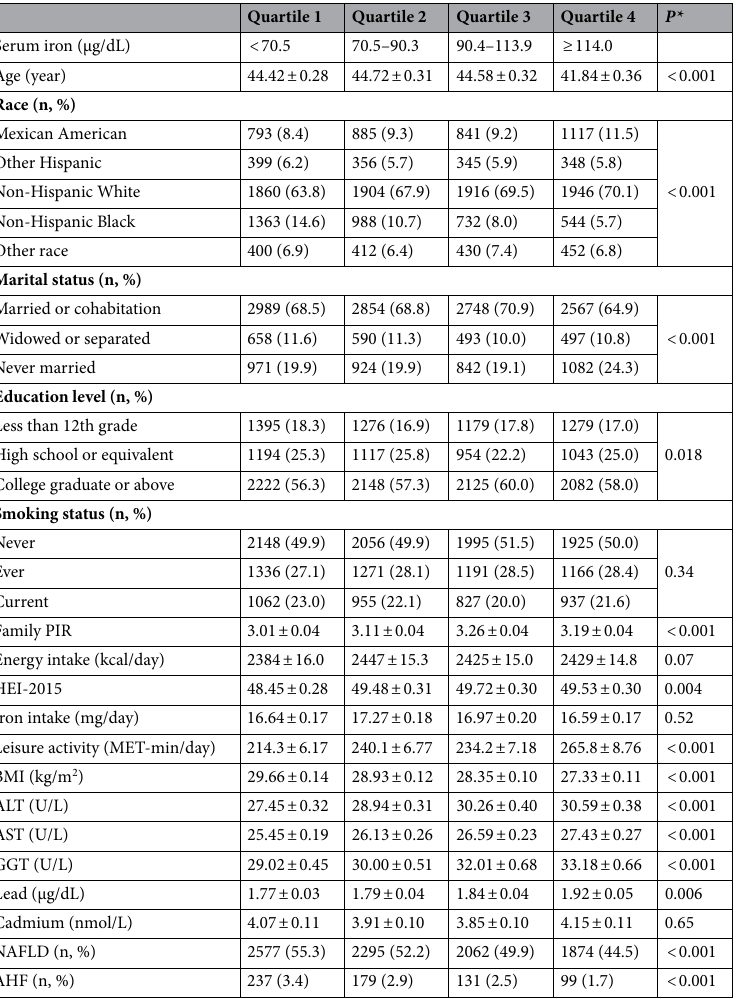
Table 1. Basic characteristics of participants according to quartiles of serum iron in males. Data were presented as survey weighted mean ± standard error for continuous variables and n (%) for categorical variables. AHF advanced hepatic fibrosis, ALT alanine transaminase, AST aspartate aminotransferase, BMI body mass index, GGT gamma glutamyl transferase, HEI healthy eating index, MET metabolic equivalent of task (MET-min/day), NAFLD non-alcoholic fatty liver disease, PIR poverty income ratio. *Unadjusted P